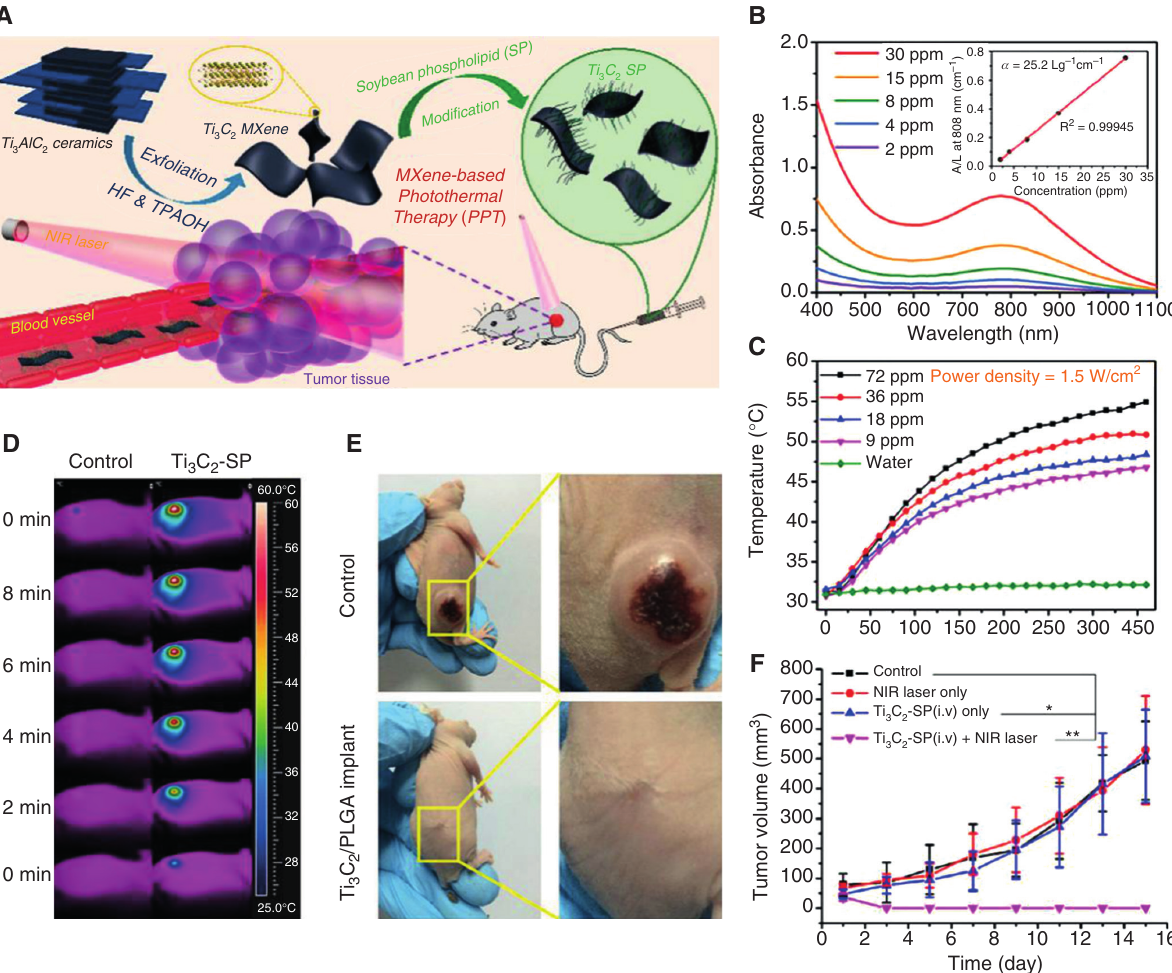
C -SP MXene nanosheets and its PTT effect in mice model. 3 2 C -SP MXene under laser irradiation. (D) Infrared images of tumor-bearing nude mice with or without 3 2